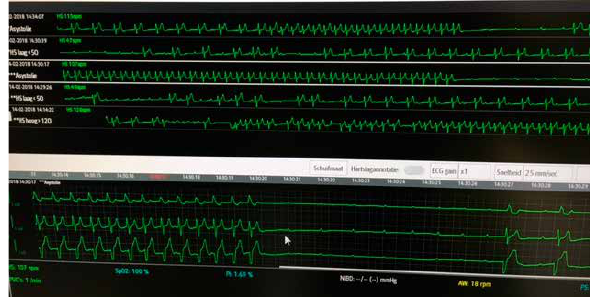
Figure 1: Third-degree atrioventricular block. During observation at the emergency department, multiple episodes of third-degree atrioventricular block were noted, the longest of which lasted 7.2 s